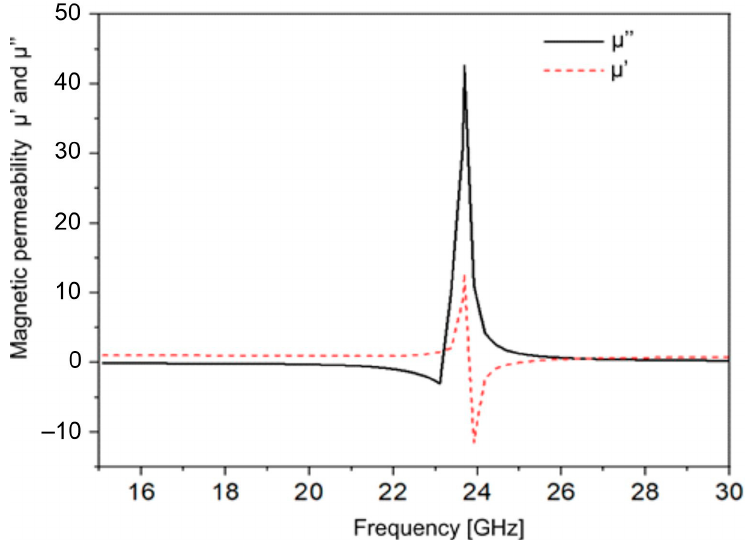
Figure 4. Frequency characteristics of the composite magnetic permeability of the tested SRR structure (µ ′ and µ ″ , the real and imaginary parts of the effective electric permeability, respectively).